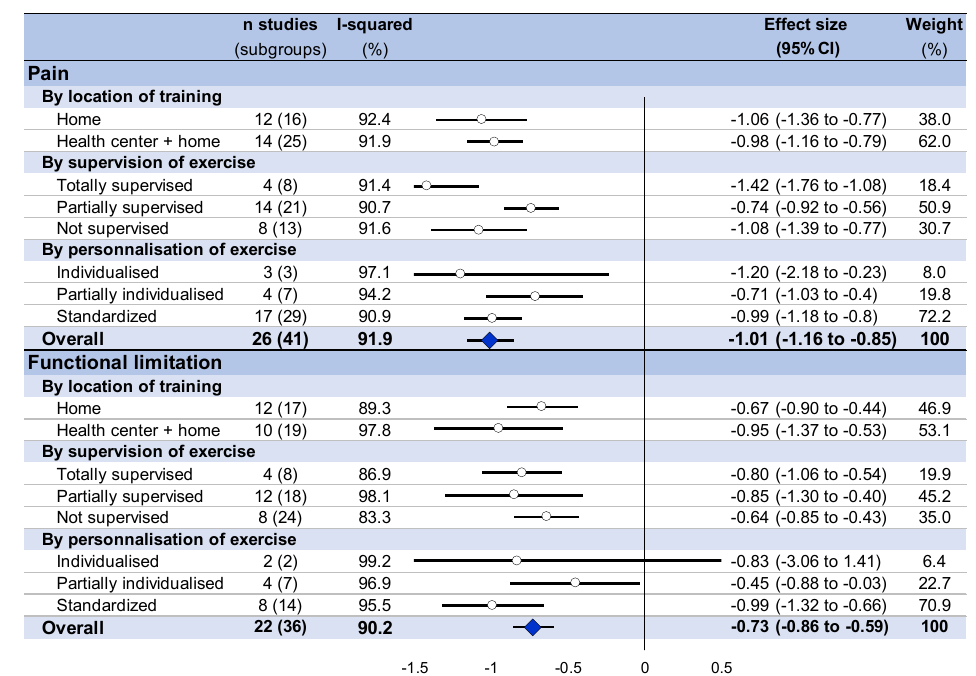
Figure A2. Summary of meta-analysis on the effect of home-based exercise on pain intensity and functional limitation, stratified by setting (exclusive home-based training versus home-based and other settings), supervision, and standardization of training), using only the median time of follow-up.